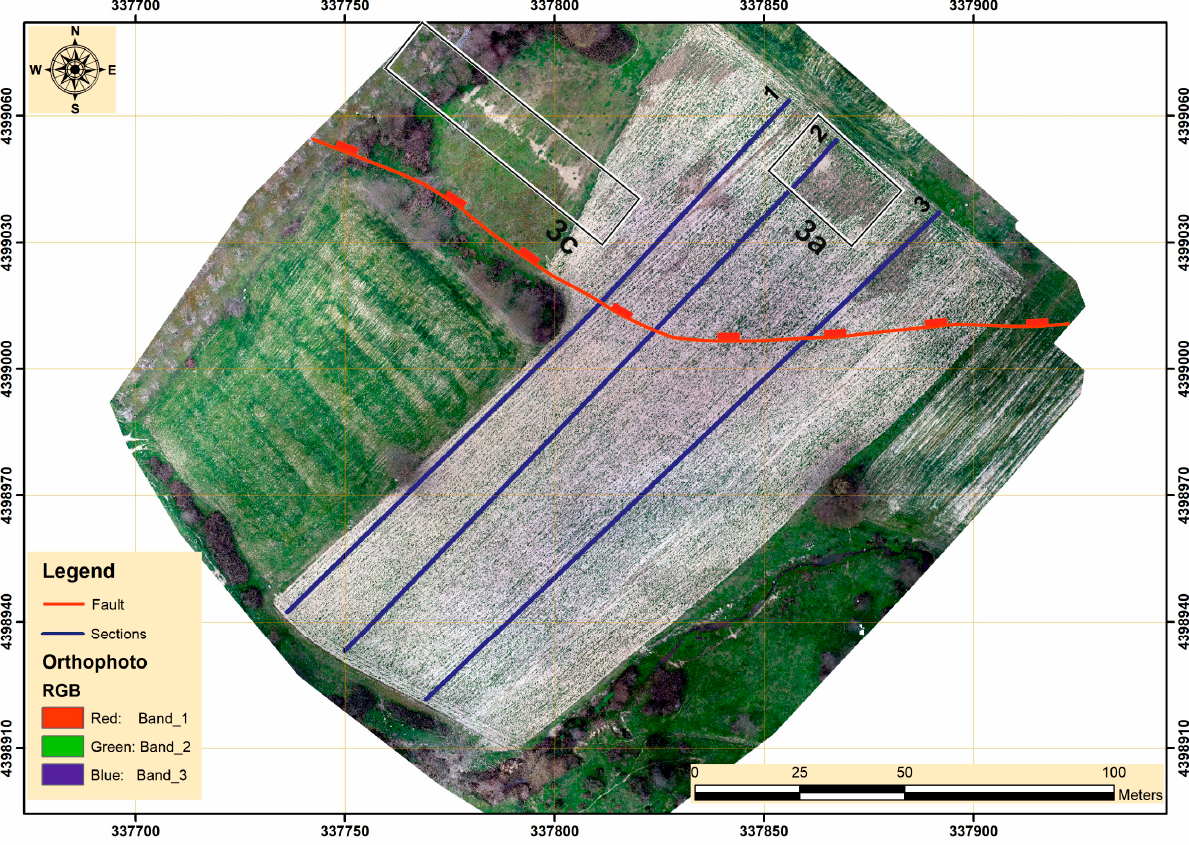
Figure 8. Orthomosaic showing location of three topographic profiles represented in Figure 7. Red line shows the co-seismic rupture.